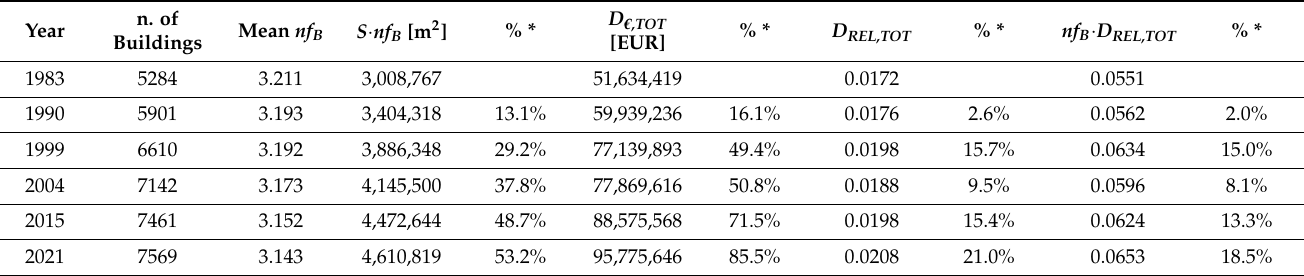
Table 2. Characteristics of exposed residential buildings through the years: number of buildings, footprint area S, average number of fl oors nf B and exposed area S ⋅ nf B (with its increase compared to 1983). Results of the model for the simulated levee failure considering the di ff erent yearly layout: total damage D €,TOT , relative damage D REL,TOT and relative damage for the fi rst fl oor nf B ·D REL,TOT (with the corresponding increase compared to 1983).